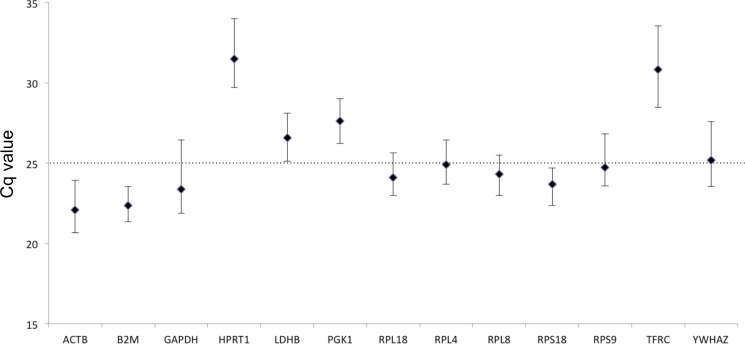
Expression levels of candidate HKGs in the tested beluga blood samples (n = 60).Values are given as qPCR cycle threshold numbers (Cq values). Dots represent mean Cq values and whiskers the range of Cq values in the 60 samples.